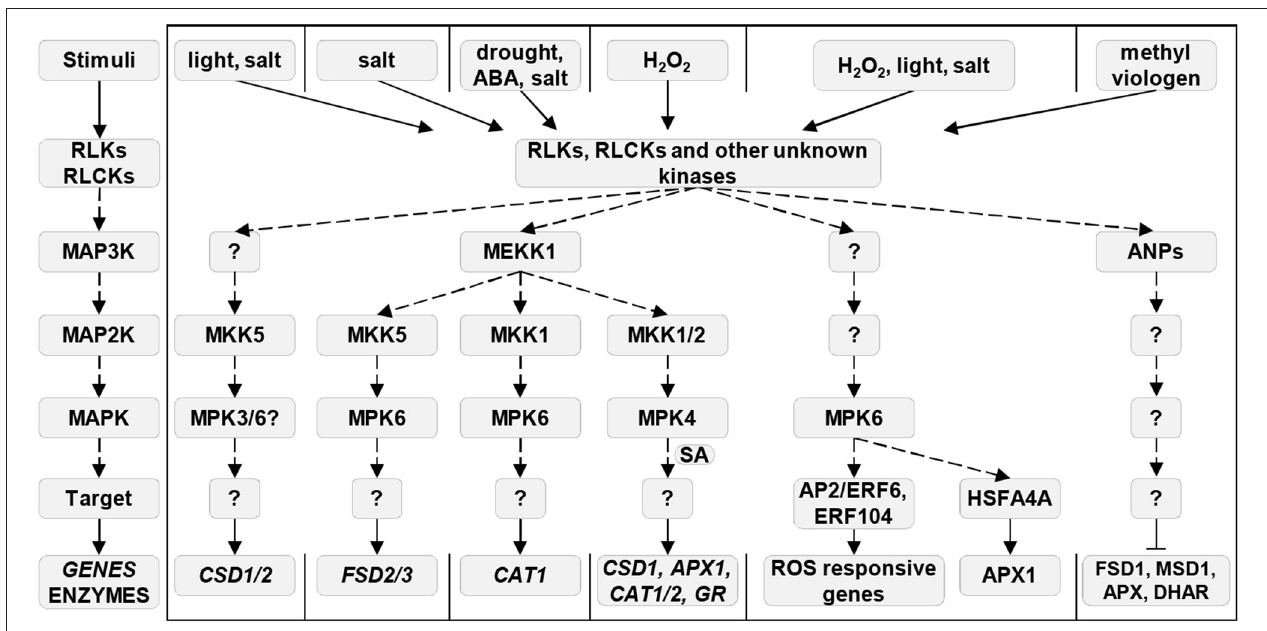
FIGURE 1 | MAPK-dependent regulation of antioxidant enzymes during plant stress responses. Most left pathway shows the universal order of a MAP3K/MAP2K/MAPK cascade. Solid arrows indicate induction, dashed arrows show phosphorylation, and ⊥ indicates negative regulation. Question mark means an unknown component of the pathway. ABA, abscisic acid; ANPs, Arabidopsis nucleus- and phragmoplast-localized kinases; AP2/ERF6, Apetala2/Ethylene-responsive element binding factor 6; APX, ascorbate peroxidase; CAT, catalase; CSD, Cu/Zn superoxide dismutase; DHAR, dehydroascorbate reductase; ERF104, Ethylene-responsive element binding factor 104; FSD, Fe superoxide dismutase; GR, glutathione reductase; HSFA4A, Heat shock transcription factor A4A; MAPK, mitogen-activated protein kinase; MAP2K, mitogen-activated protein kinase kinase; MAP3K, mitogen-activated protein kinase kinase kinase;